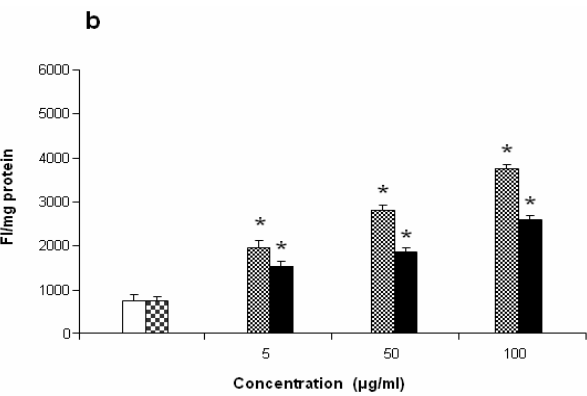
Figure 7: Reactive oxygen species (ROS) production by MeT-5A (a) and J774 (b) cells measured by 2’7’- dichlorodihydrofluorescein diacetate (DCFH-DA) in untreated control and cells treated with various amounts of antigorite. The values, expressed as fluorescence intensity (FI) units per mg of protein, are the mean ± SEM of three experiments performed in triplicate. * - denotes values significantly (P<0.01) different from untreated control.